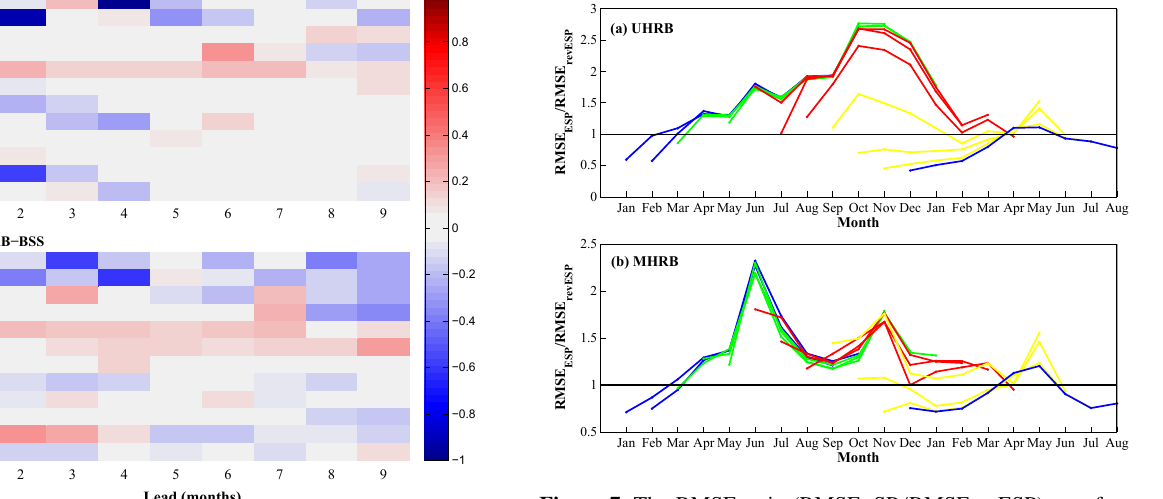
Figure 7. The RMSE ratio (RMSE E SP / RMSE r evESP) as a func- tion of start month and lead time over the upstream and midstream. The RMSE ESP (RMSE revESP ) is calculated between the SSI1 series from the offline simulation and that from the ESP (revESP) experi- ments with the human activities module switched